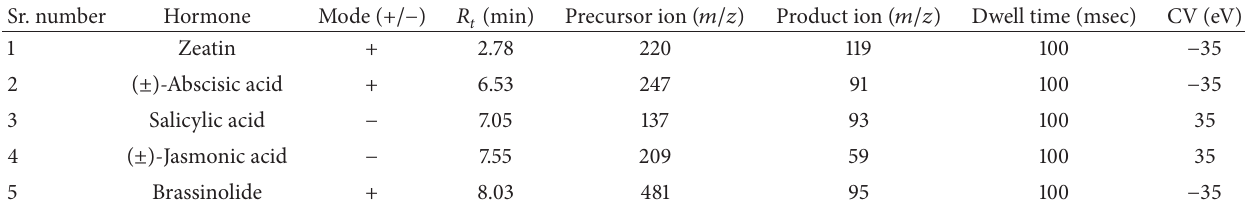
Table 1: Optimized multiple reaction monitoring mode (MRM) conditions for the analysis of plant hormones. Sr.